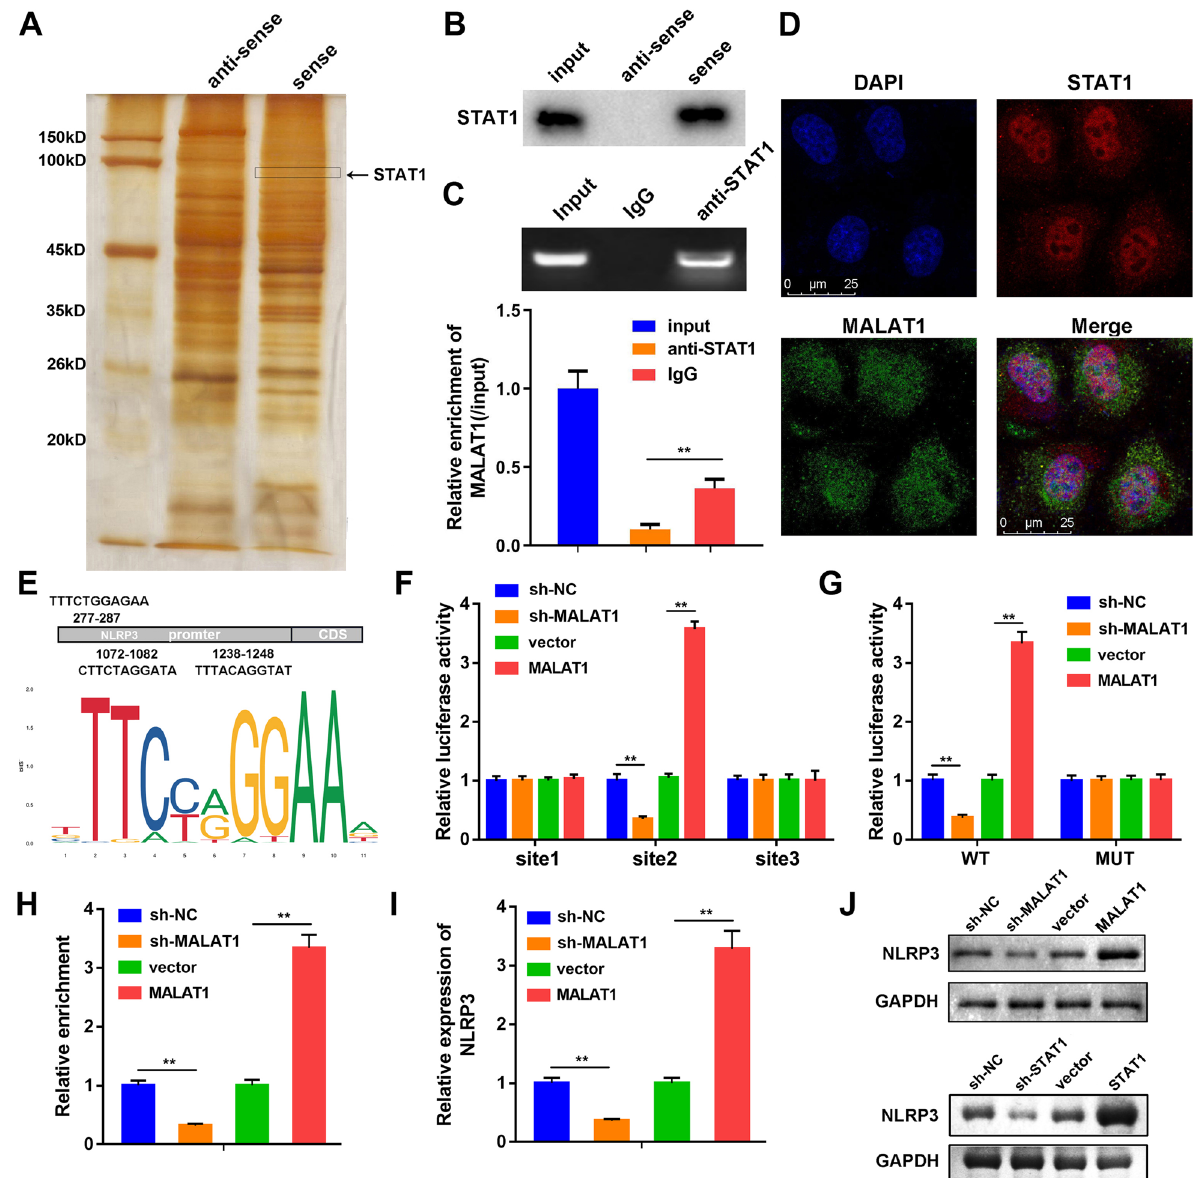
Fig. 5 MALAT1 positively regulated NLRP3 expression level through binding to STAT1. A The protein bands of sense and anti-sense MALAT1 groups after RNA-pull down assay was performed. STAT1 was marked in the image. B RNA pull-down assay for STAT1 in input, anti-sense and sense MALAT1 groups. C MALAT1 enrichment of input, IgG and anti-STAT1 groups were detected by RIP assay. The MALAT1 relative enrichment was normalized on input. D FISH result exhibited the subcellular localization of MALAT1 (red) and STAT1 (green) of the BV2 cells. The cells were hybridized with the Cy-2 labeled anti-STAT1 and Cy-7 labeled MALAT1 probes. E The potential binding site sequences of STAT1 with NLRP3 (upper). DNA binding motif of STAT1 predicted by Jaspar (lower). F Relative luciferase activities of the BV2 cells were detected 48 h after transfection of luciferase reporter vectors. G Relative luciferase activities of the BV2 cells were detected 48 h after they were transfected with wild and mutant types STAT1 luciferase reporter vectors. H The affinity of STAT1 in the promoter of NLRP3 detected using ChIP assay. I NLRP3 levels in the the BV2 cells were measured by RT-qPCR after MALAT1 knockdown or overexpression. J Western blot for NLRP3 of the BV2 cells transfected with indicated ad-shRNA or overexpression plasmids. (n 3), ** P<0.01, NC, negative control. Cite 1, the sequence of NLRP3 promoter regions 277–287; cite2, the sequence of NLRP3 promoter = regions 1072–1082; cite2, the sequence of NLRP3 promoter regions